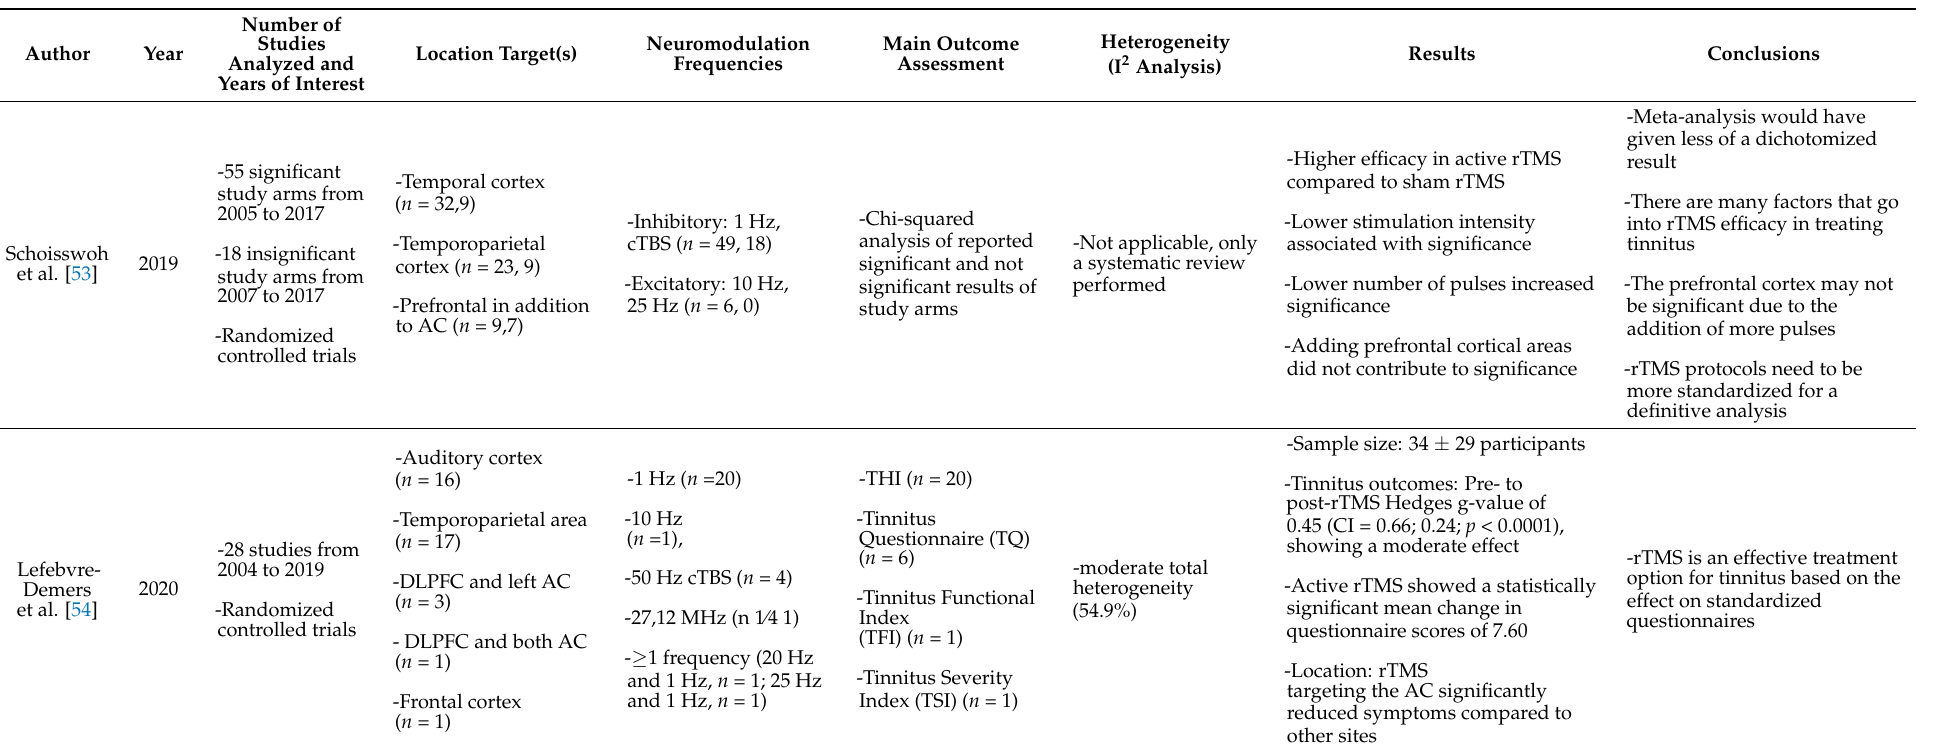
Table 3. Meta-analyses and systematic reviews: Summary of characteristics, results, and conclusions of 1 systematic review and 3 meta-analyses of RCTs regarding the efficacy of rTMS for the treatment of